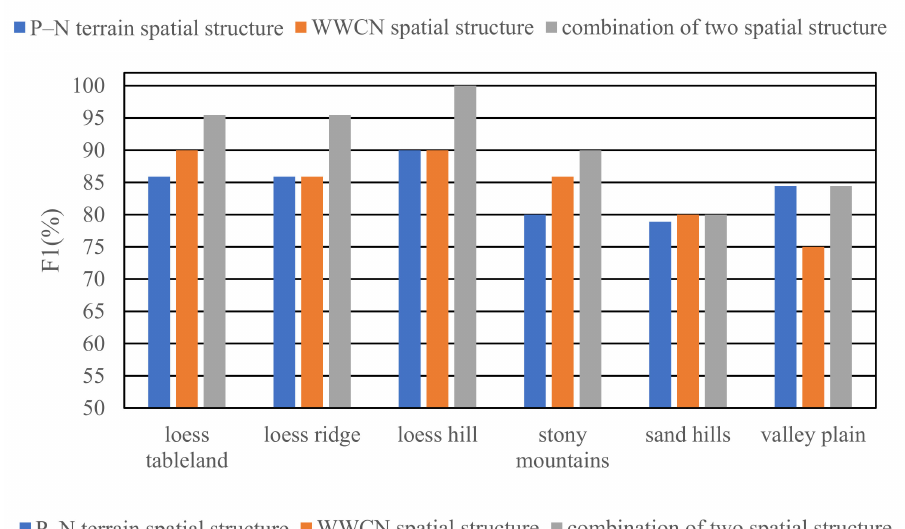
Figure 11. The comparison between the P–N terrain spatial structure, WWCN spatial structure, and the combination of the two